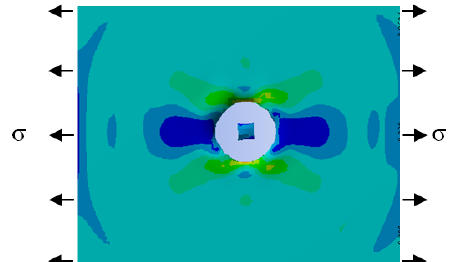
Figure 3: Snapshot of the evolution of the stress field after the hole was instantly formed in the loaded